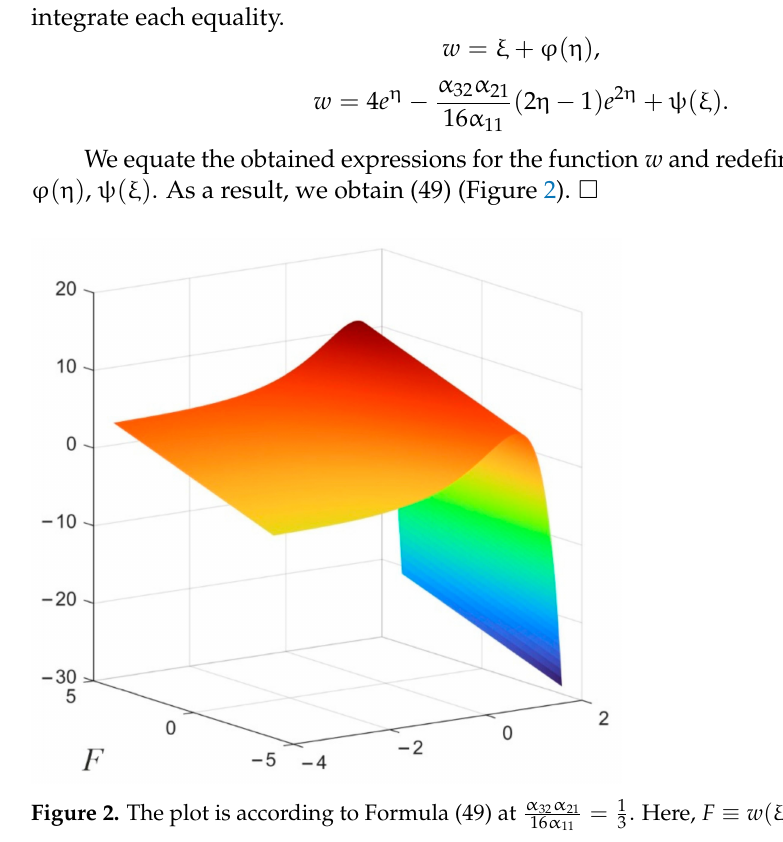
Figure 2. The plot is according to Formula (49) at α 32 α 21